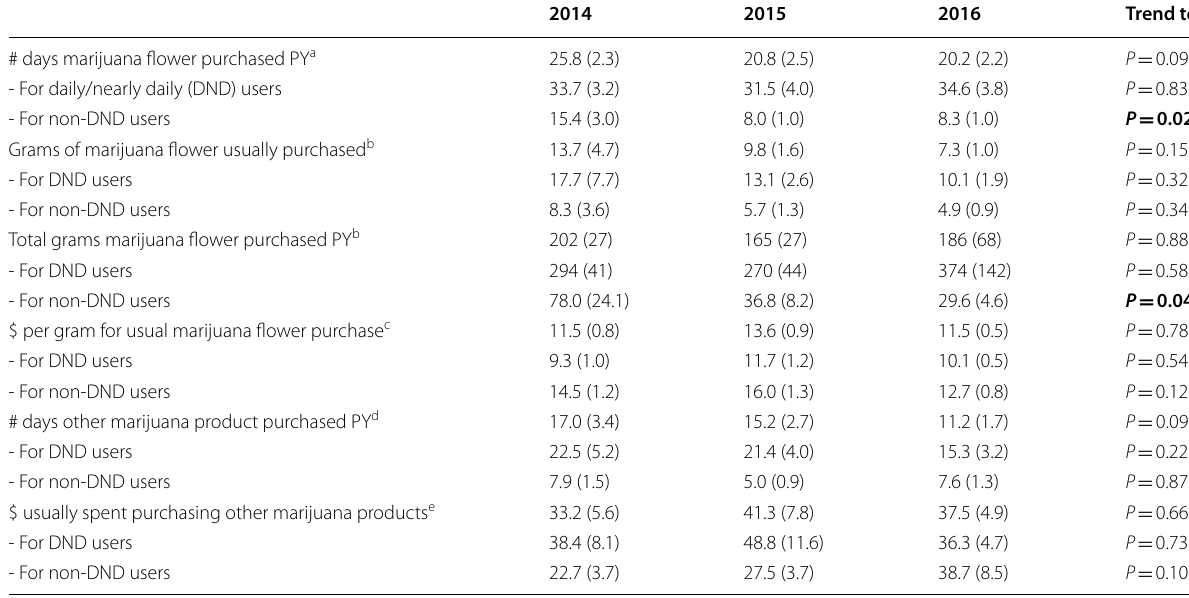
Table 2 Means (SE) for marijuana flower and other marijuana products purchase quantity, frequency, and expenditure for